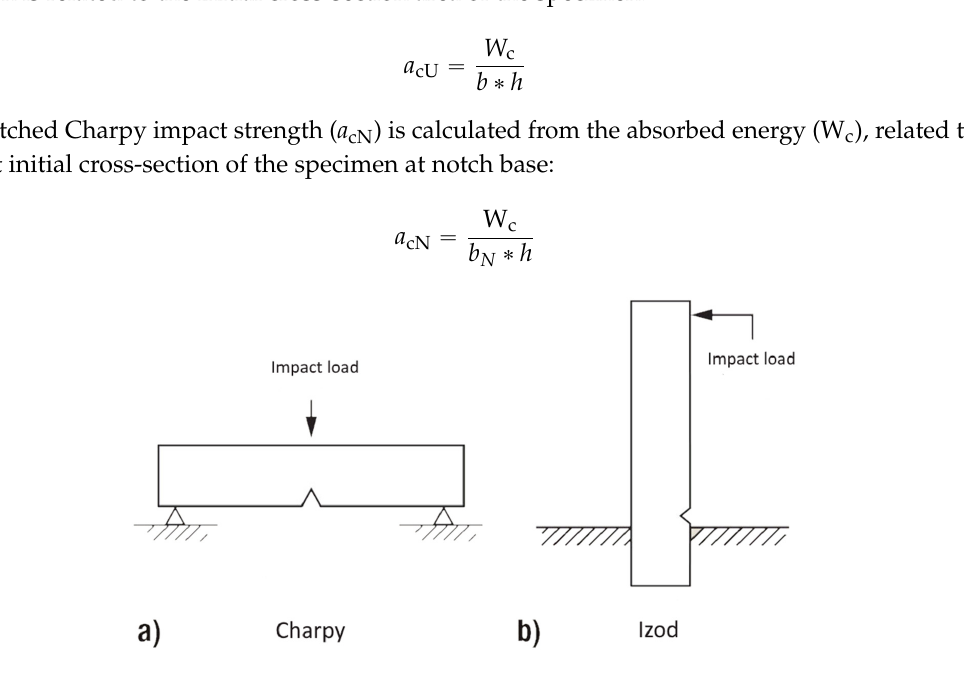
Table 3. Flexural modulus values of epoxy based thermosets measured in 3 point bending mode.